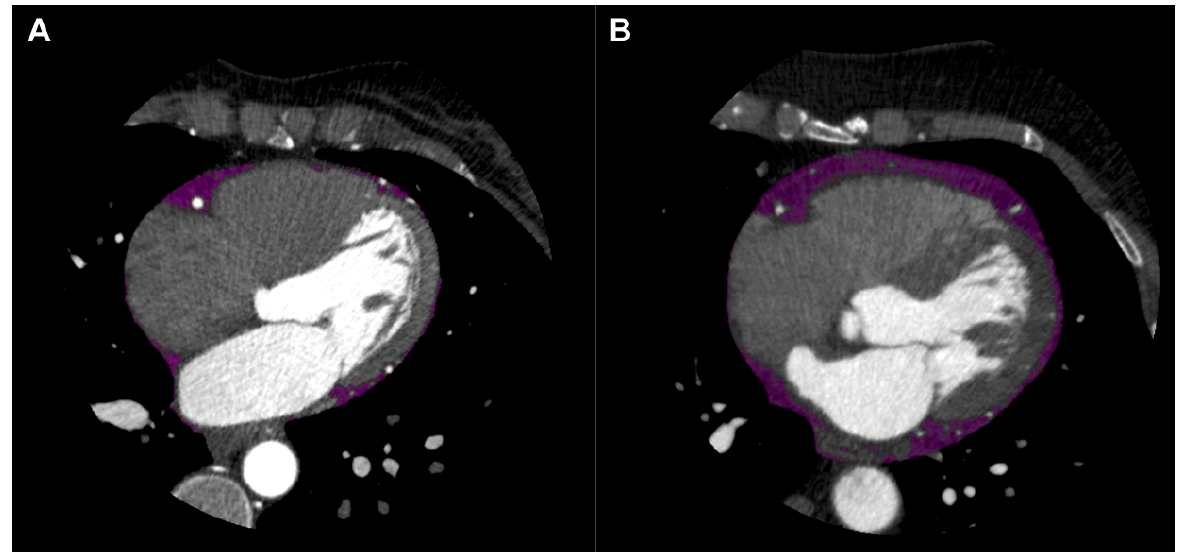
Figure 2. Epicardial adipose tissue (EAT) shown in purple on axial view of coronary computed tomography angiography (CTA). EAT in patient without coronary artery disease (CAD) shown in left panel ( A ), and EAT in patient with CAD shown in right panel ( B ).